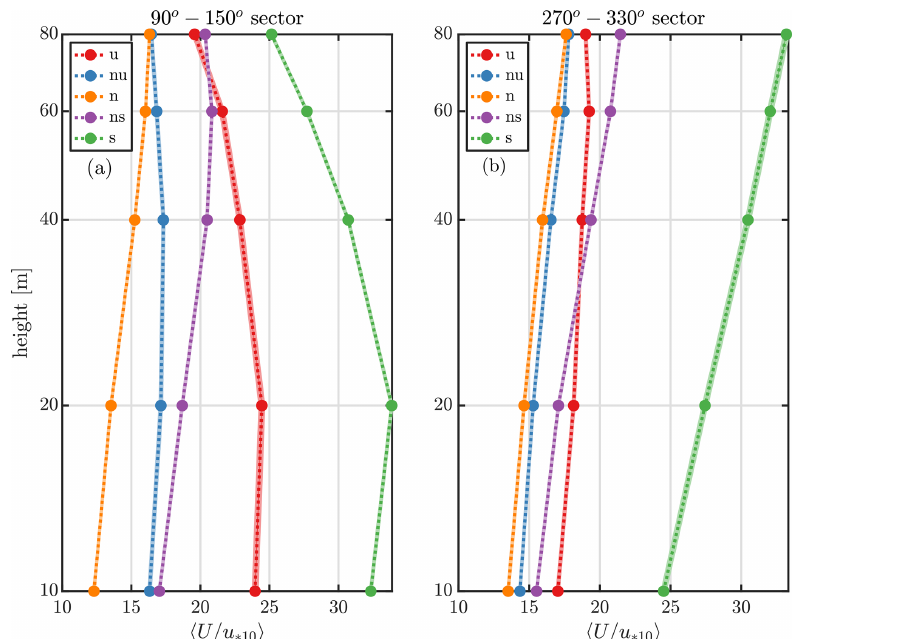
Figure 8. Mean vertical wind profiles normalized with the friction velocity computed by the 10min sonic anemometer ( u ∗ 10 ). Panel (a) shows profiles within the 120 ± 30 ◦ sector, and panel (b) shows profiles within the 300 ± 30 ◦ sector based on wind directions at 10m. Shaded areas denote associated standard errors of the